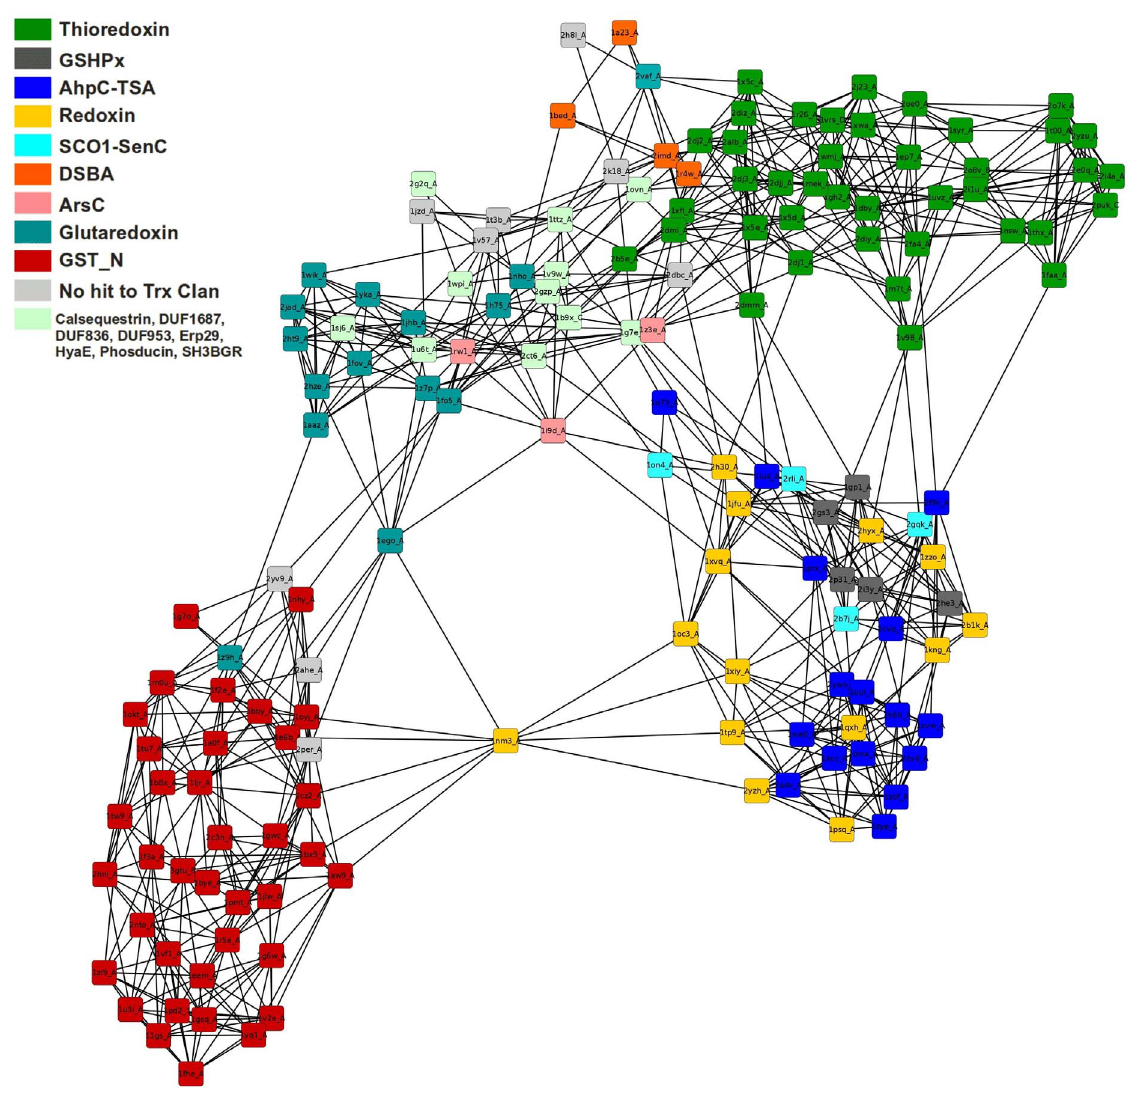
Figure 2. Protein similarity network of Thioredoxin-like structures. The PDB codes of structures from a previous publication [23] are used in PANADA to derive a network representation coloured by functional class. The organic layout was generated in Cytoscape with PANADA default parameters. The correspondence between colour codes and functional groups is shown in the upper left part. Notice how structures with the same functional class form tightly packed cluster separated from each other by a few connecting structures.